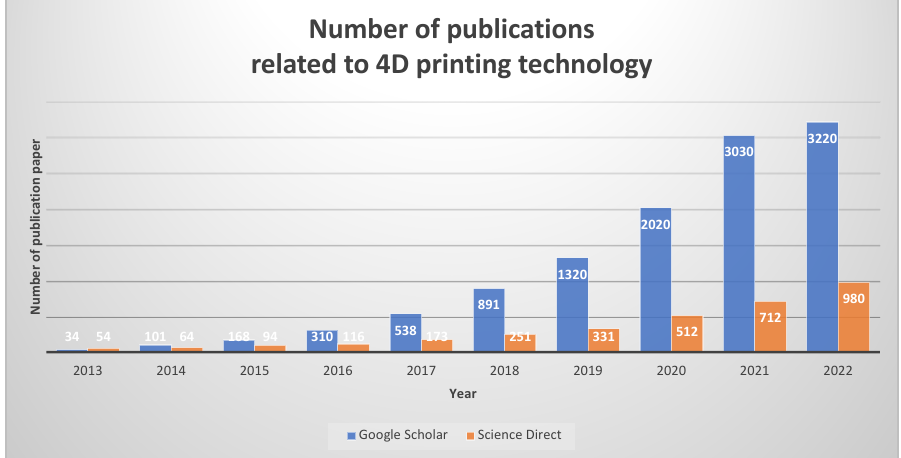
Figure 1. Number of publications in Google Scholar and ScienceDirect databases with the keyword “4D printing” (as of 30 November 2022).